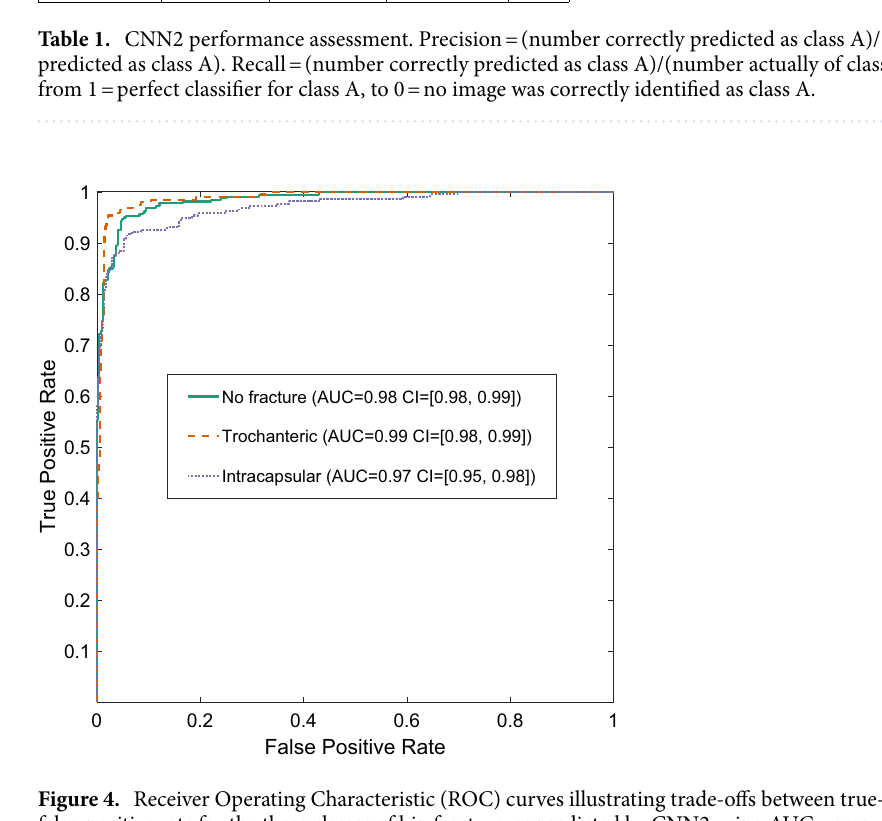
Figure 4. Receiver Operating Characteristic (ROC) curves illustrating trade-offs between true-positive and false-positive rate for the three classes of hip fracture, as predicted by CNN2 using AUC = area under the curve, given with the 95% confidence interval